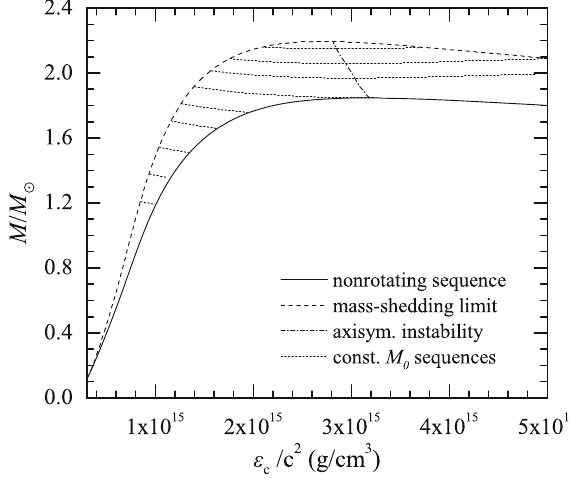
Fig. 2 Representative sequences of rotating stars with fixed baryon mass, for EOS WFF3 (Wiringa et al. 1988). Above a rest mass of M 0 = 2 . 17 M (cid:3) only supramassive stars exist, which reach the axisymmetric instability limit when spun down. The onset of axisymmetric instability approximately coincides with the minima of the constant rest mass sequences. (Image reproduced with permission from Friedman and Stergioulas 2013, copyright by the authors)